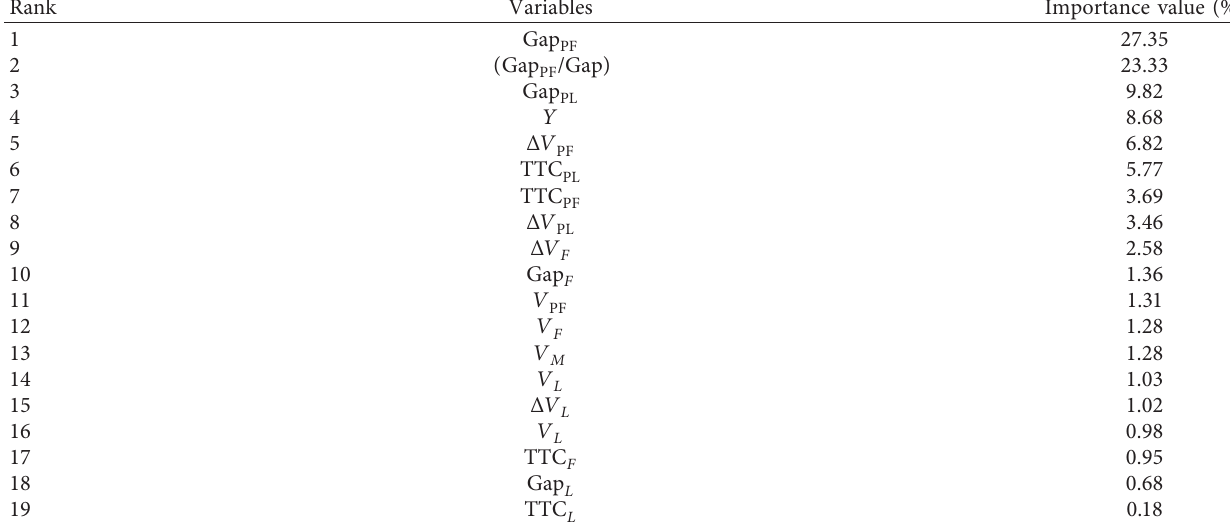
Table 6: Rank of variable